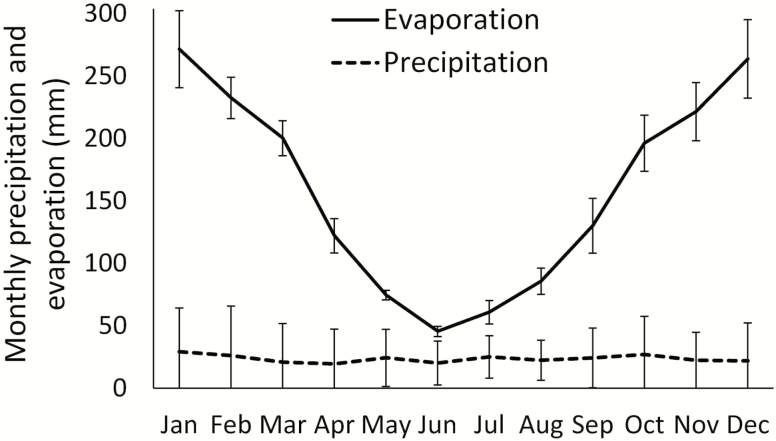
Mean monthly precipitation, from 1956 to 2016 (BOM 2018) and mean monthly evaporation, from 2013 to 2018 (Environdata 2018) at the study site. Error bars represent standard deviation.